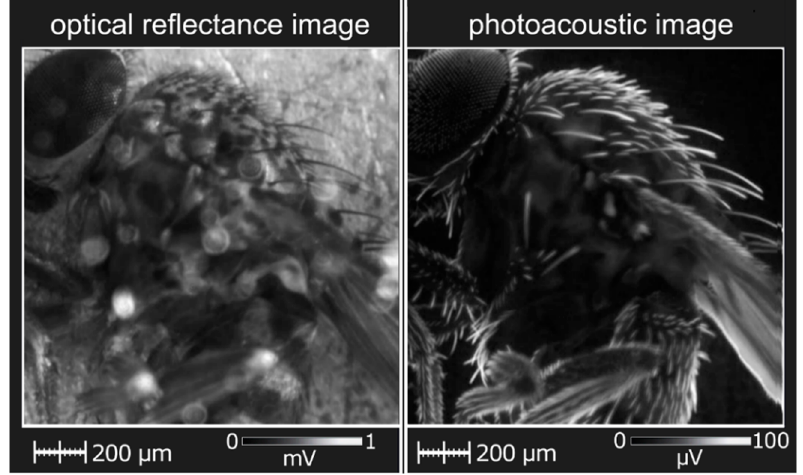
Figure 9. PAT images of a Drosophila fly obtained by a bi-modal system in the reflected light and PA mode.